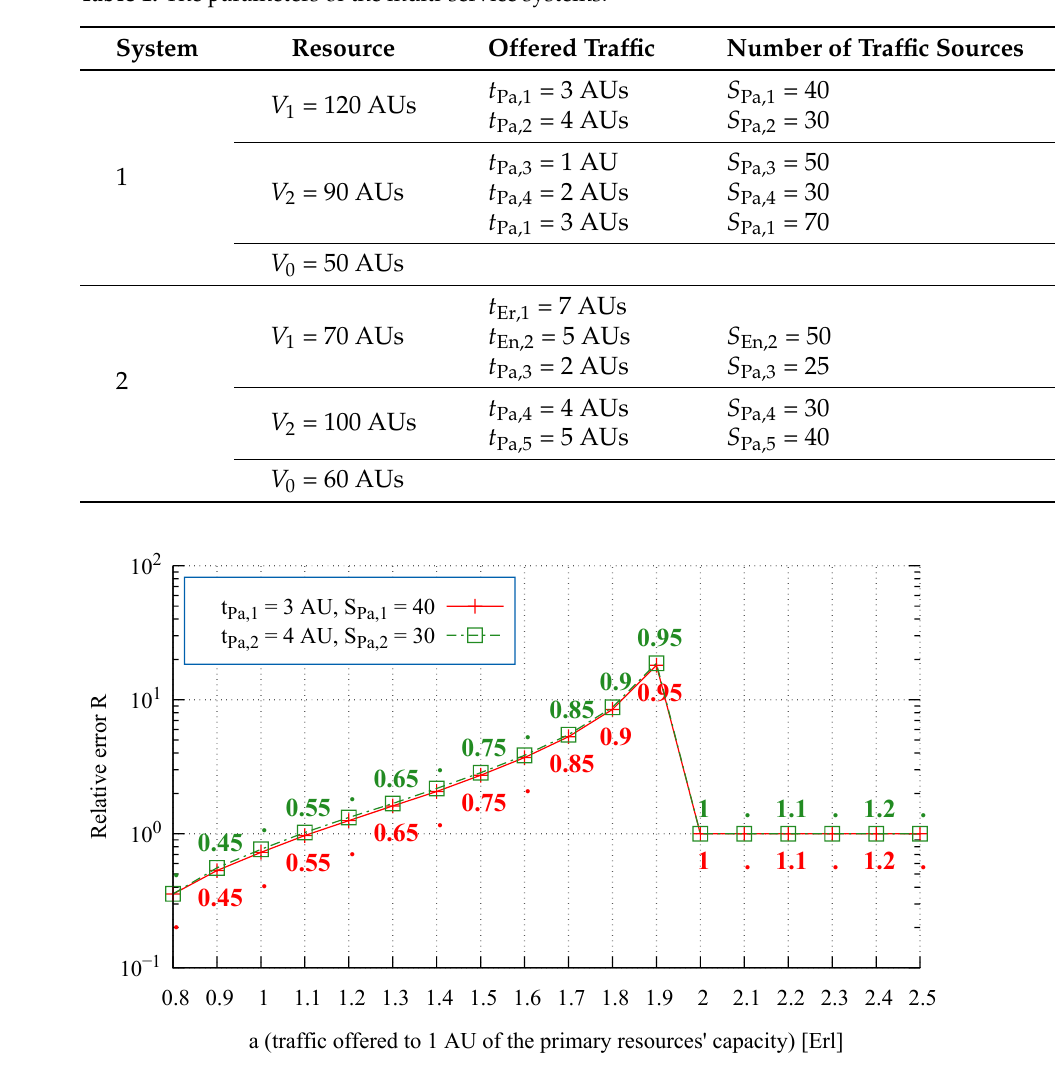
Figure 3. Relative error of the average value of overflow traffic, System 1, Resource 1 ( α values specified directly in the